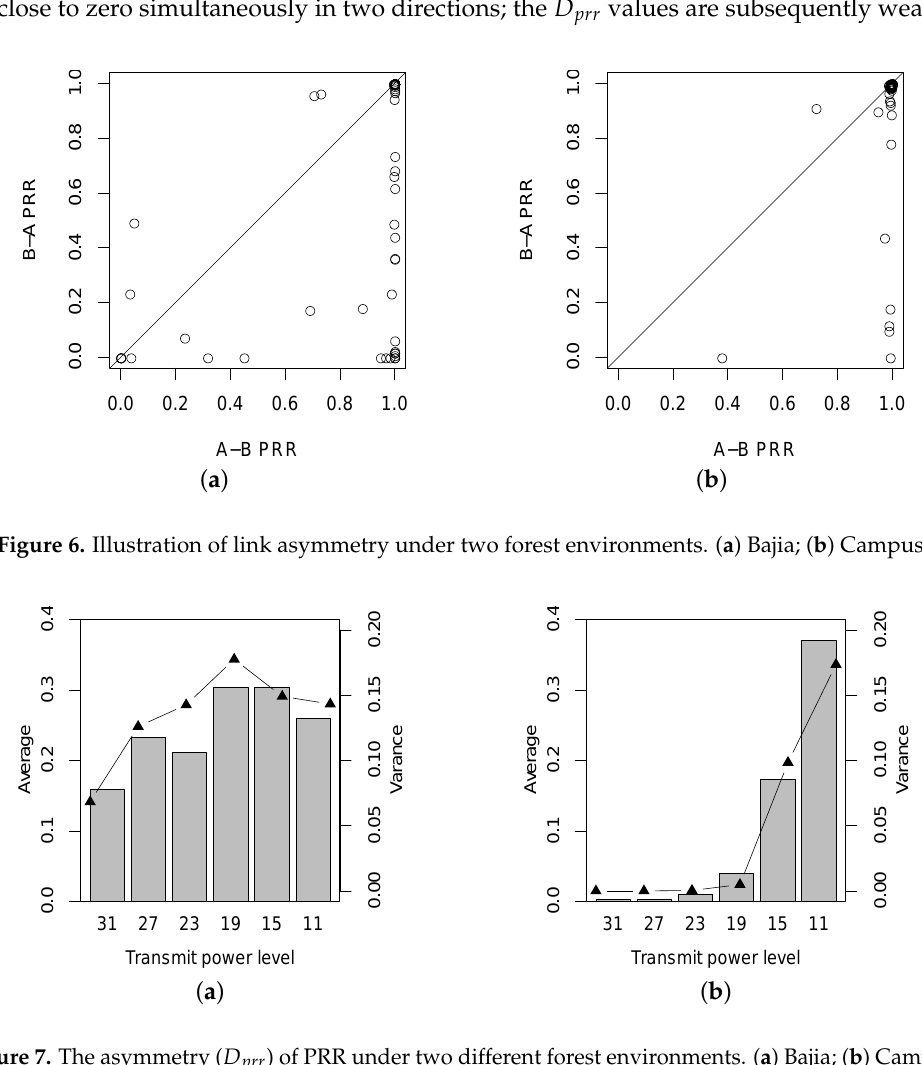
Figure 7. The asymmetry ( D prr ) of PRR under two different forest environments. ( a ) Bajia; ( b )